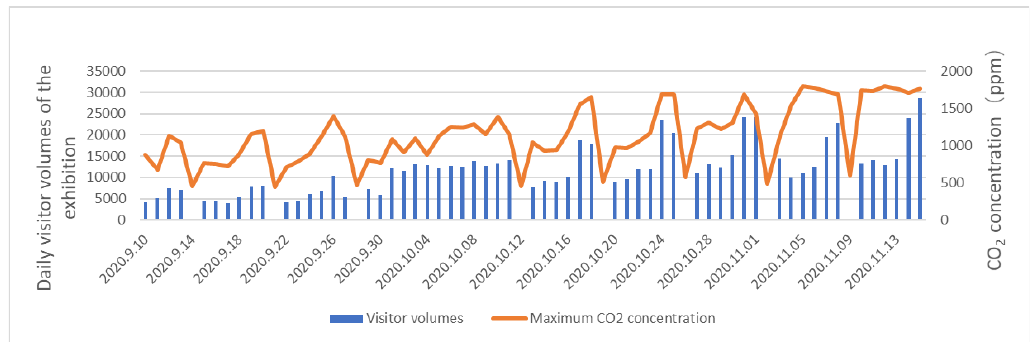
Figure 5. Comparison of visitor volumes and CO 2 concentration during the development